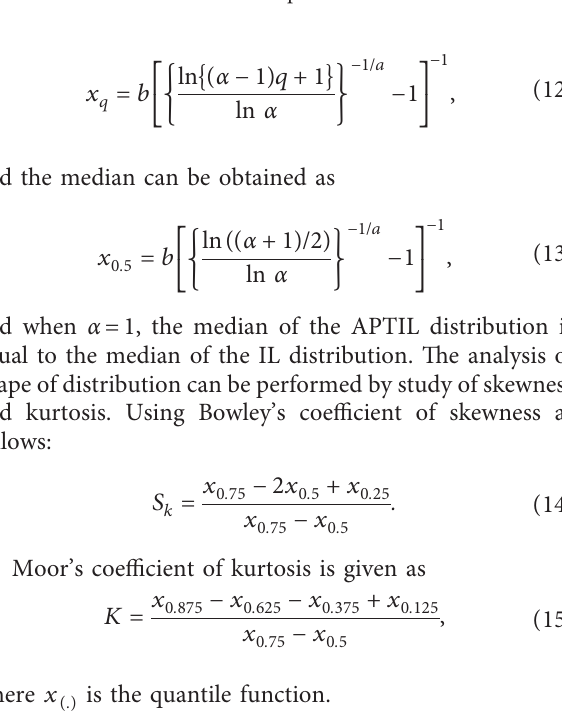
Figure 1: Plots of the pdf and hrf of the APTIL distribution for different values of